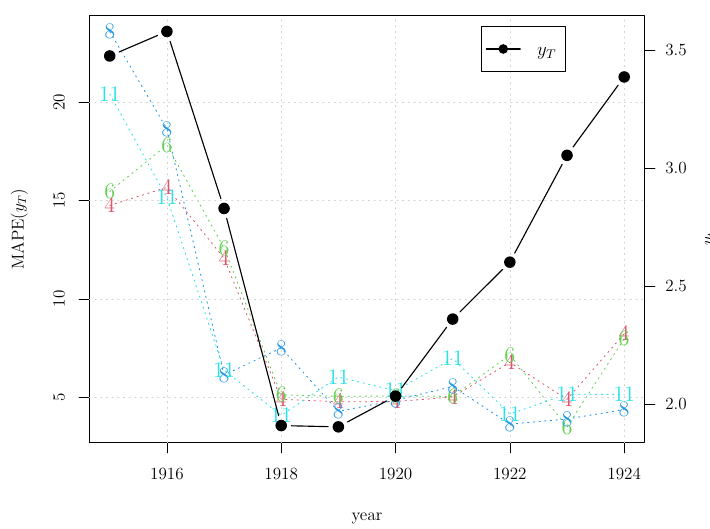
) versus y for the models M4, M6, M8 and M11. The black line is T T , T = 1915,...,1924, i.e. the end point of each T